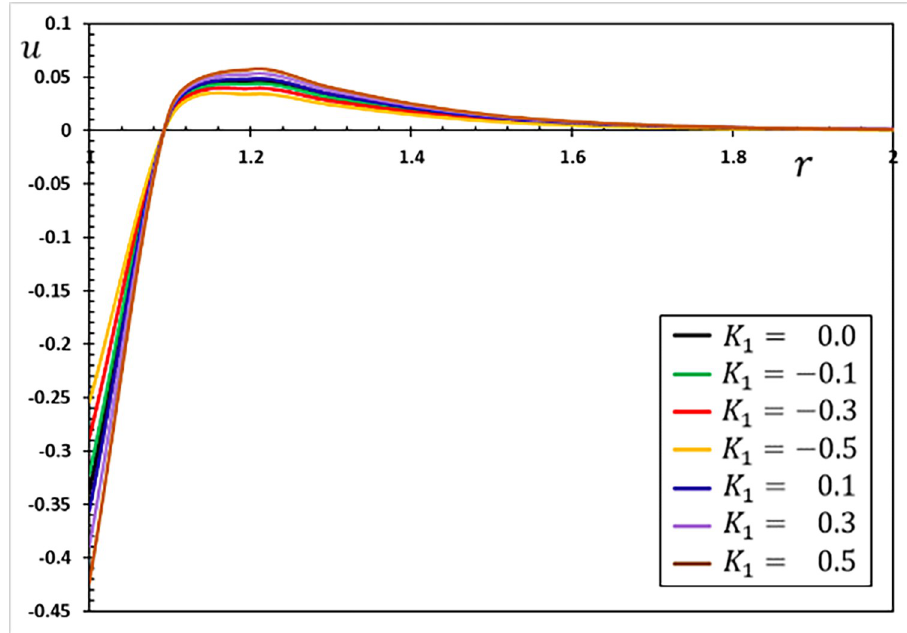
Fig 2. The displacement variation u for different values of the parameter K 1